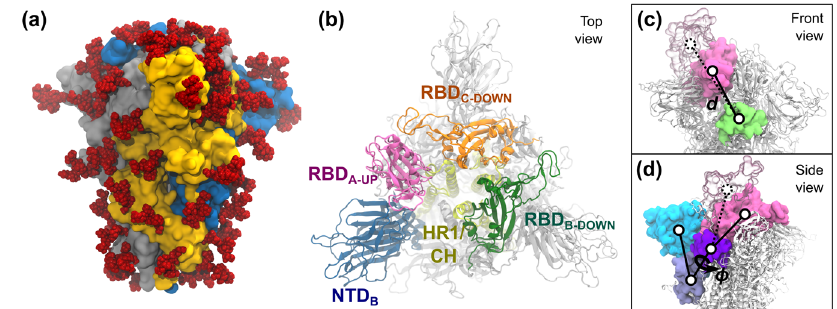
Fig. 1 S protein of SARS-CoV-2. a The trimeric S protein in the all-down state, colored by protomer. Glycans are shown as red spheres. b Top view of the S protein in the one-up state. Important domains of the spike are highlighted, including the N-terminal domain (NTD, 14 – 306), the receptor binding domains (RBD, 336 – 518), the heptad repeat 1 (HR1, 908 – 986), and the central helix (CH, 987 – 1035). c , d The two collective variables de fi ned to describe the opening of RBD-A include: c the center-of-mass distance d between RBD-A (336 – 518, pink) and SD1-B (531 – 592, lime), and d the dihedral angle ϕ formed by the center of mass of the domains RBD-A (336 – 518, pink), SD1-A (531 – 592, purple), SD2-A (593 – 677, ice blue), and NTD-A (27 – 307, cyan). RBD-A in both the down (solid pink) and up (transparent pink) states